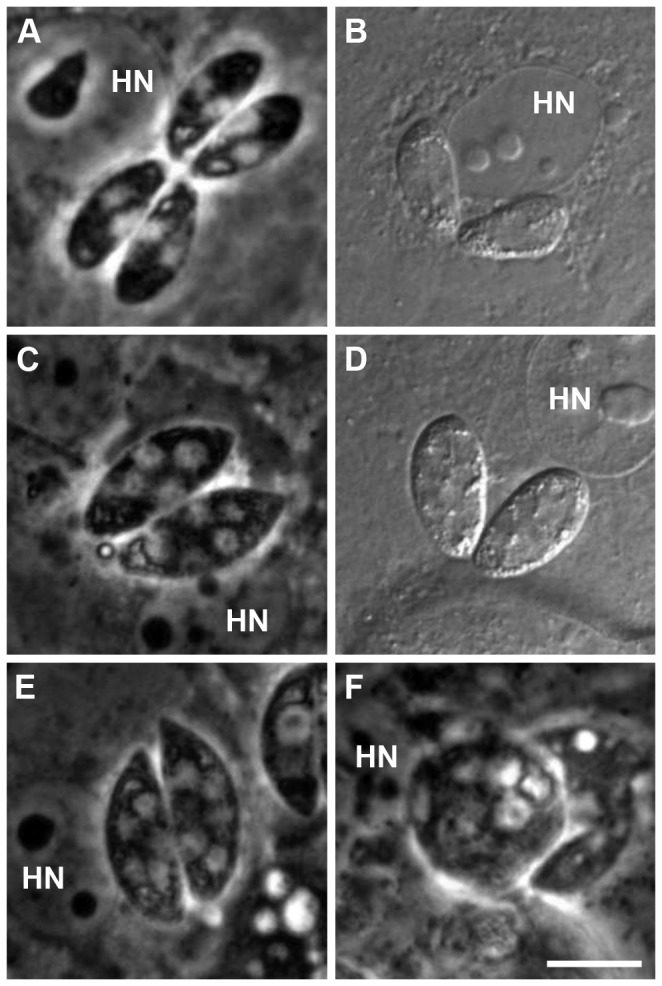
Meronts of

I

. suis
 in the in vitro culture in intestinal porcine epithelial cells (IPEC-J2).(A) PC image on dpi 9 and (B) DIC image at dpi 3 of bi-nucleated type I meronts; (C) PC and (D) DIC image of symmetric type II meronts with multiple nuclei; (E) PC image of asymmetric type II meronts on dpi 9; (F) rounded multinucleated subtype II meront on dpi 9. DIC, differential interference contrast; dpi, days post infection; HN, host cell nucleus; PC, phase contrast; bar = 10 µm.